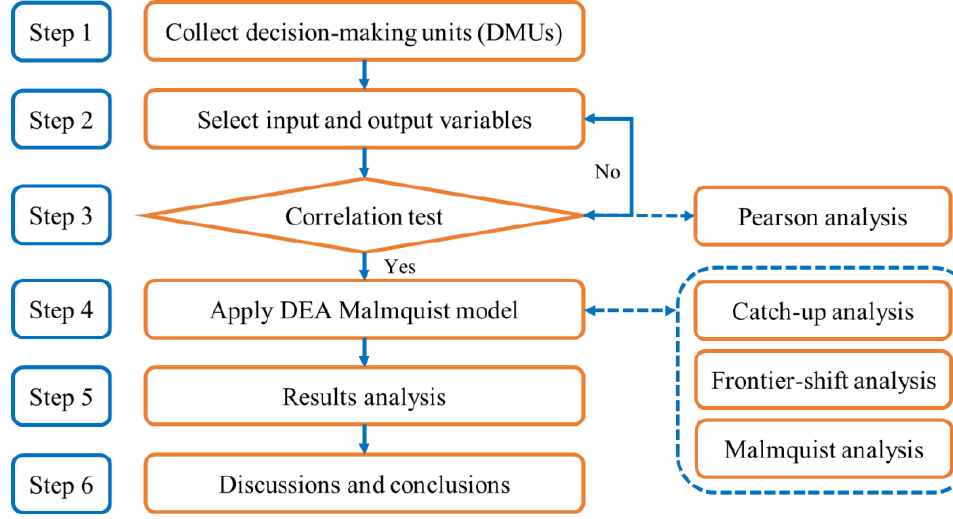
Figure 1. Research